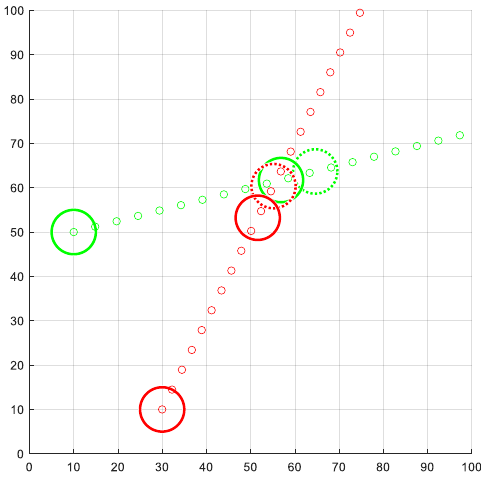
Figure 3. Example of conflict prediction ( 𝑟 = 5 𝑚 ; 𝑣 = 10 𝑚/𝑠 ). The two UAVs maintain a conflict from 𝑡 = 4.83 𝑠 (solid lines) to 𝑡 = 5.63 𝑠 (dotted lines).